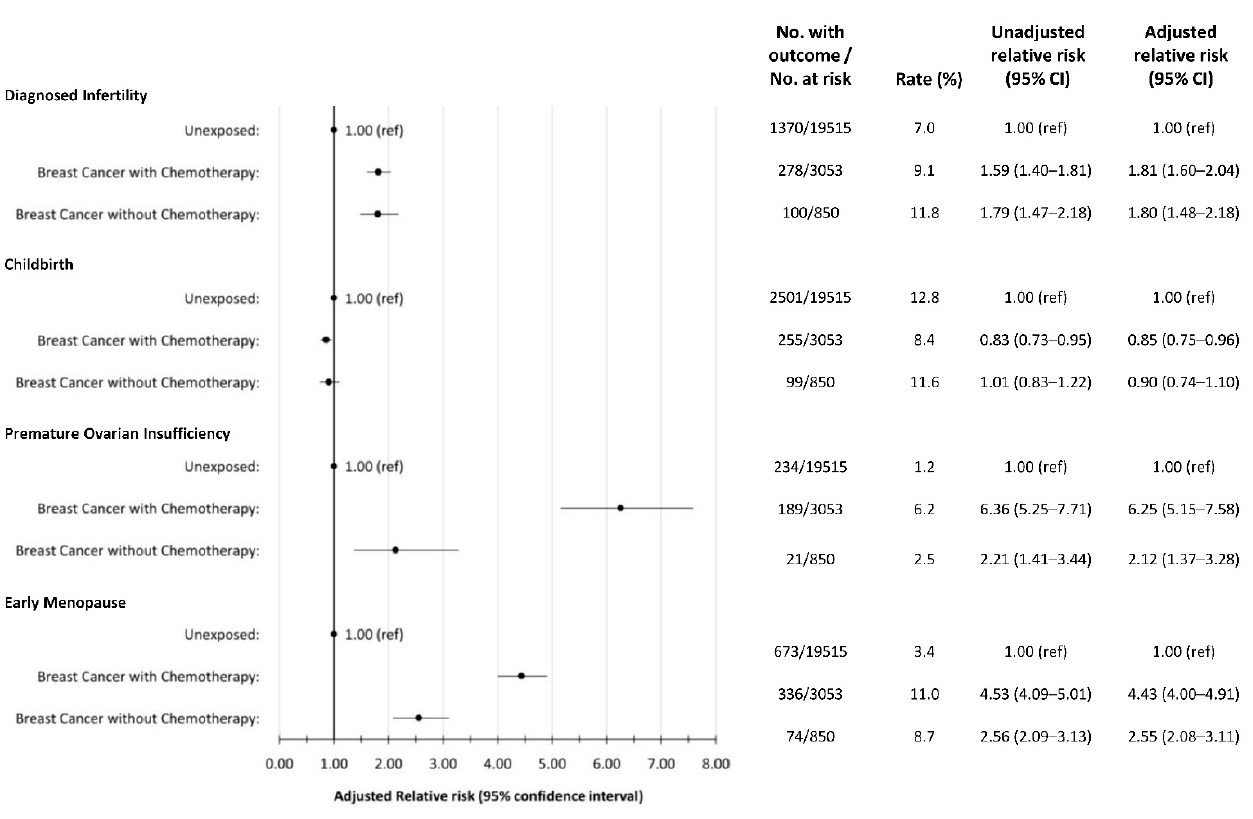
Figure 2. Forest plot depicting rates and relative risks (RR) with 95% confidence intervals for each outcome of interest by exposure and treatment group.